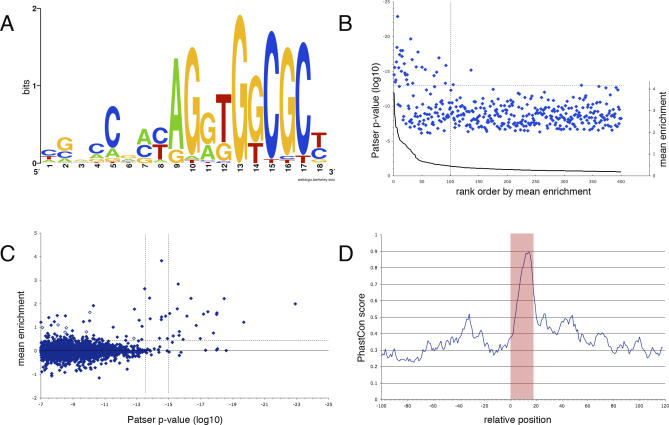

Drosophila CTCF In Vivo Binding-Site Consensus(A) Shown is the sequence logo of the CTCF consensus.(B and C) Correspondence between ChIP enrichment and closeness of match to the CTCF consensus is presented.(B) The top 600 enriched fragments are ordered by Mn (equivalent to log2ratio, black line), and the corresponding Patser p-values are plotted (blue diamonds). The blue horizontal dotted line indicates Patser p < 10−13, which approximately marks the boundary of the p-value distribution associated with nonenriched fragments. The black vertical dotted line indicates the position in the rank order of Mn = 0.45.(C) The lowest Patser p-value for each fragment is plotted against the Mn for that fragment (blue diamonds). Open diamonds indicate fragments with p > 10−13 that are neighbours to fragments with lower p-values. The horizontal dotted line indicates Mn = 0.45. Candidate enriched fragments were selected on Mn > 0.45 and CyberT p < 0.05. The vertical dotted lines indicate the positions of Patser p = 10−13.5 and 10−15.(D) PhastCons scores are shown across all 855 predicted genomic CTCF binding sites with a Patser p < 10−15. The binding sites are centred over position 0, and 100 bp left and right of the site are shown. The blue line indicates the median PhastCons score for a given position. There is a prominent peak corresponding to the CTCF motif. The flanking sequences show some minor fluctuations in conservation of unclear significance.